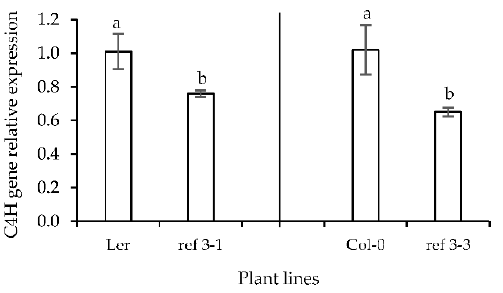
Figure 10. C4H gene expression profile of Arabidopsis thaliana wild-type (set at 1.0) and less-lignin mutant seedlings on 0.7% ( w / v ) Micro-agar. Different letters indicate significant differences between mutant seedlings on 0.7% ( w/v ) Micro-agar. Different letters indicate significant differences between means at α = 0.05 means at α = 0.05 level.